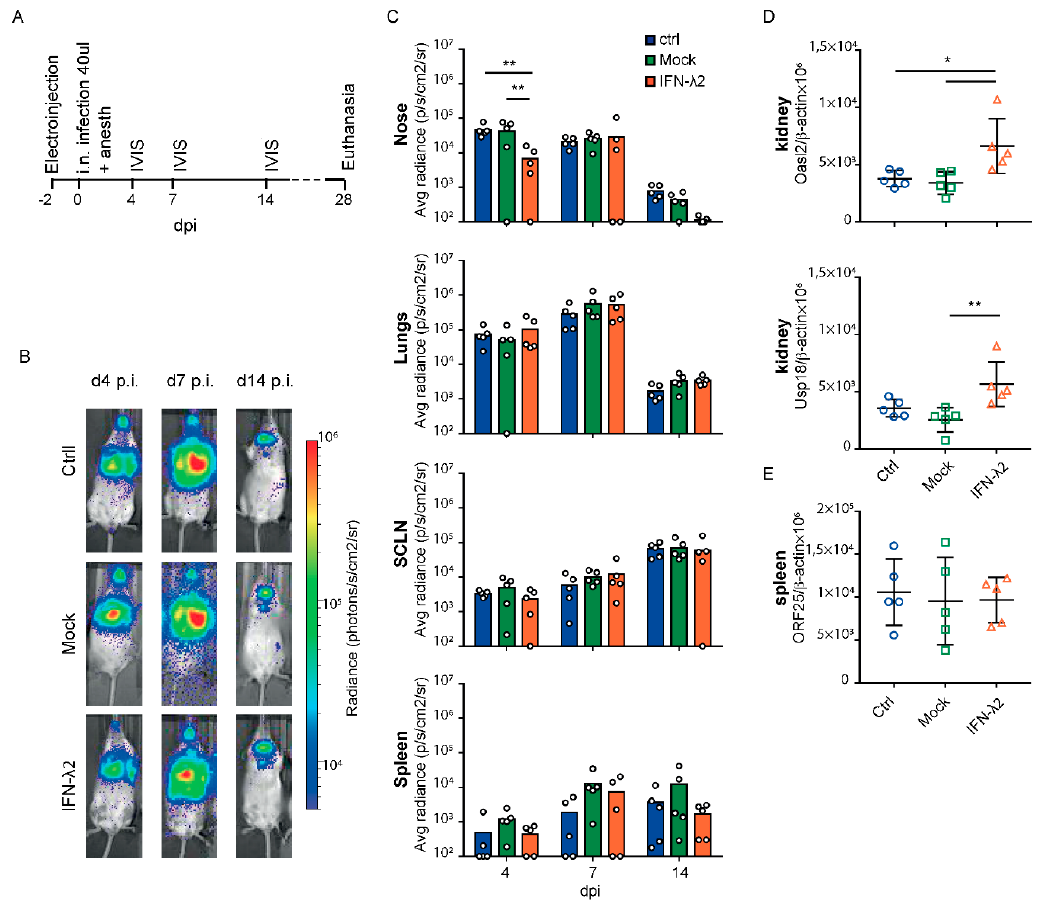
Figure 2. Bioluminescence analysis of MuHV-4 after intranasal inoculation under general anesthesia in mock or IFN- λ -treated mice. ( A ) Eight week-old female BALB/c mice were electroinjected with an empty plasmid (mock, n = 5) or a plasmid expressing IFN- λ 2 (IFN- λ 2, n = 5). A control group (ctrl, n = 5) was left untreated. Two days later, mice were infected intranasally with 10 4 PFU Luc+ MuHV-4 in 40 μ L under general anesthesia and imaged at the times indicated. ( B ) Representative images are shown for ctrl, mock or IFN- λ 2 electroinjected groups at days four, seven, and 14 post infection (p.i.) ( C ) Signal intensities were compared for the nose, lungs, superficial cervical lymph nodes (SCLNs) and spleen between groups. The signal was determined by measuring equivalent regions of interest and subtracting the right abdominal signal as a negative background. The graphs show mean and individual values. ( D ) Amounts of Oasl2 and Usp18 per 10 6 β -actin cDNA copies detected in the left kidney of mice at the time of sacrifice. ( E ) Viral genome copy numbers (ORF25) per 10 6 β -actin copies in spleen at the time of sacrifice showed no significant difference between groups. ( C – E ) Two-way ( C ) and one-way ( D , E ) ANOVA: * p < 0.05 and ** p < 0.01; no mark—no significant difference.